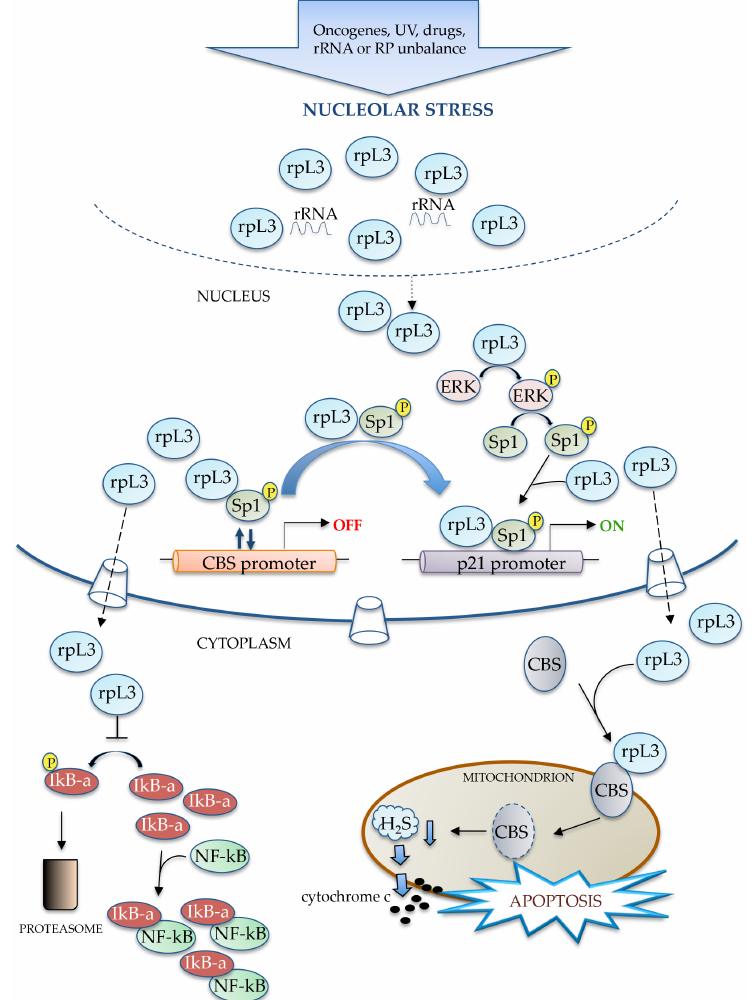
Figure 4. Model of p53-independent and rpL3-dependent response pathways to nucleolar stress. CBS: cystathionine- β